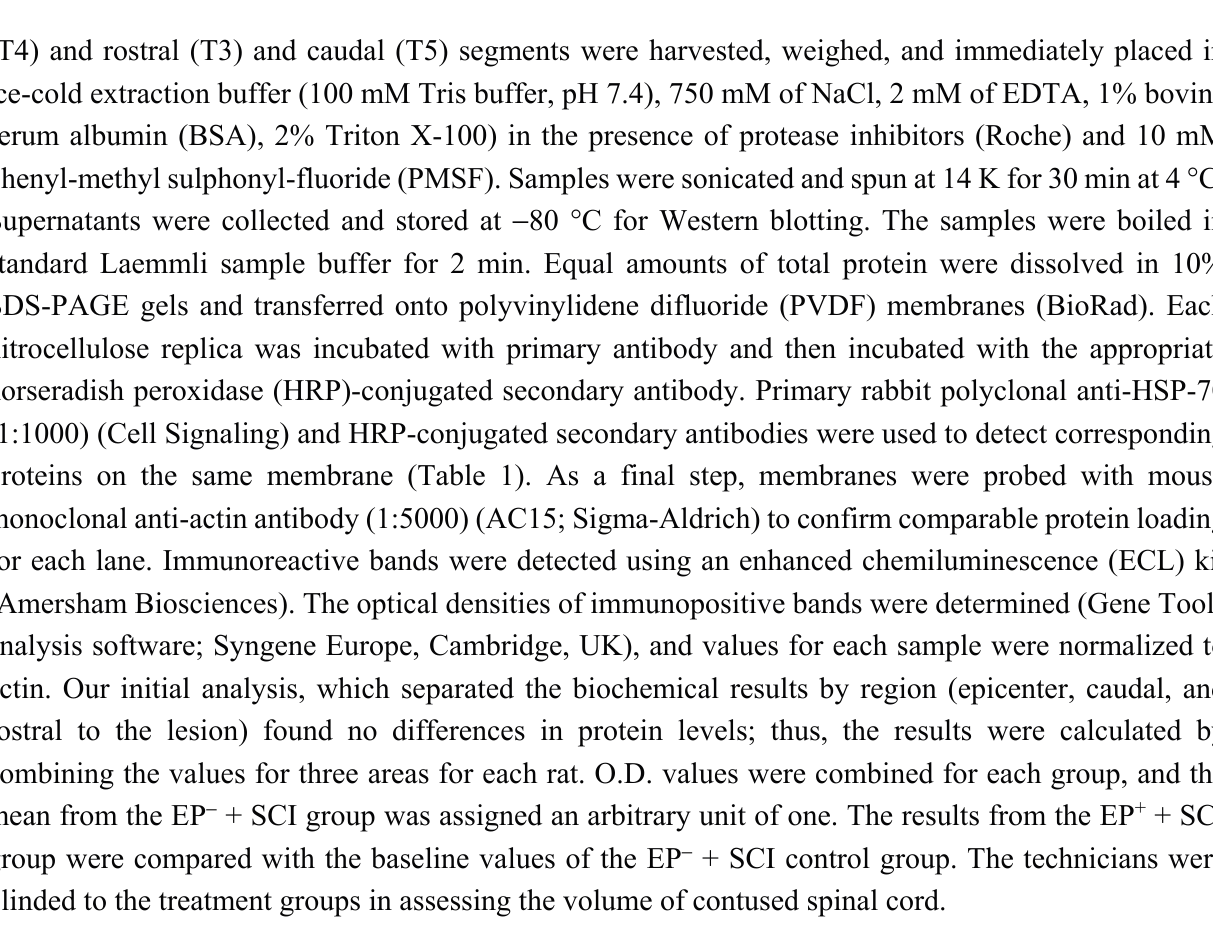
Table 1. Western blotting in a spinal cord injury rat